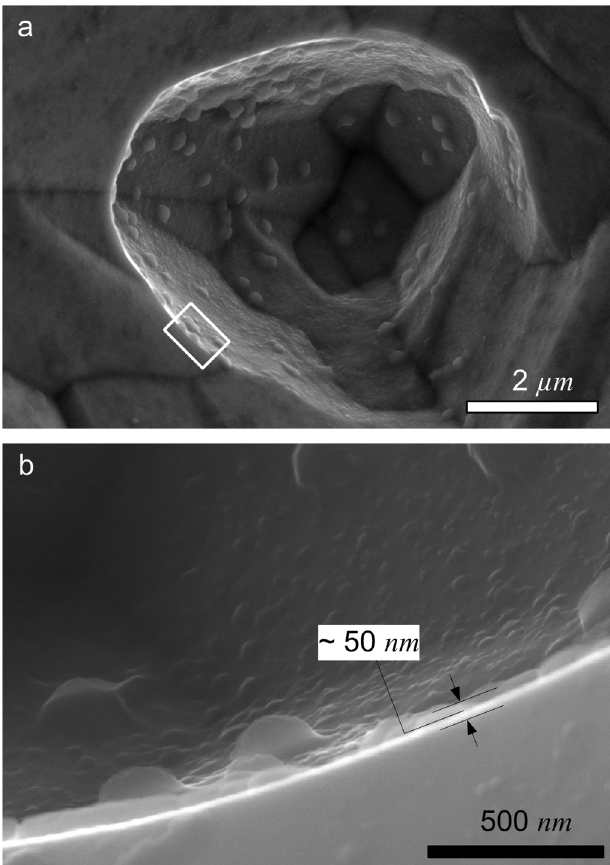
FIG. 8. SEM image showing the tricrystal etch pit found on sample 5. The pit has deep, sharp profiles. The pit diameter is (cid:1) 5 (cid:1) m and its edge curvature radius (cid:1) 50 nm as estimated from a higher resolution SEM images shown in (b).